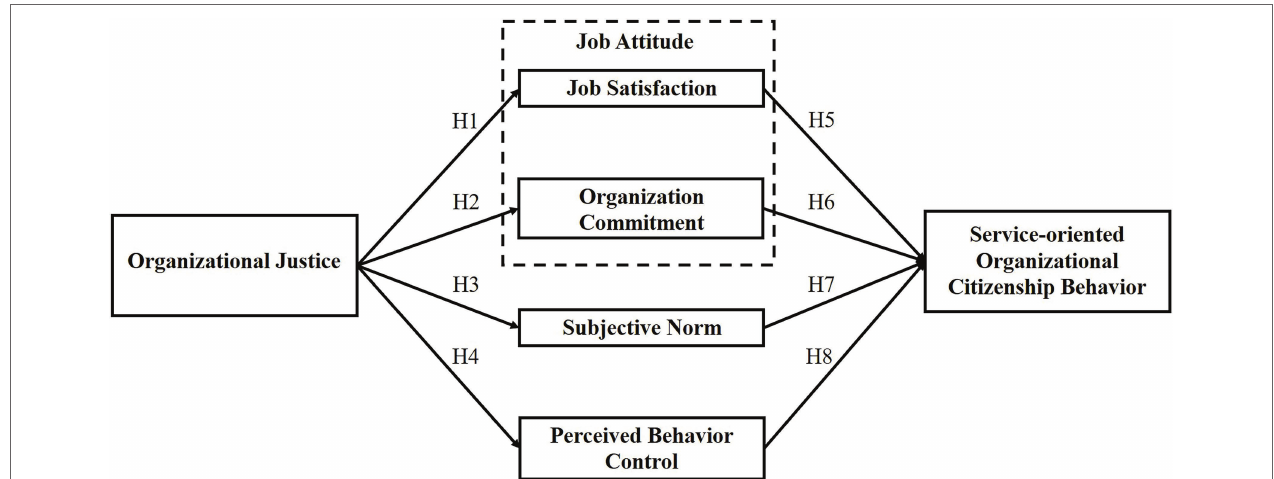
FIGURE 1 | Research